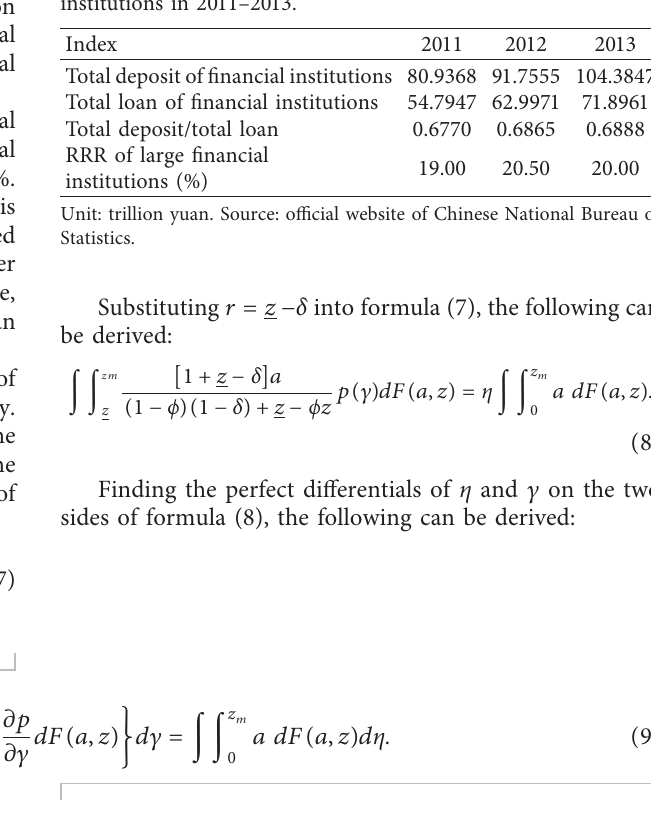
Table 1: Deposit balance and loan balance of Chinese